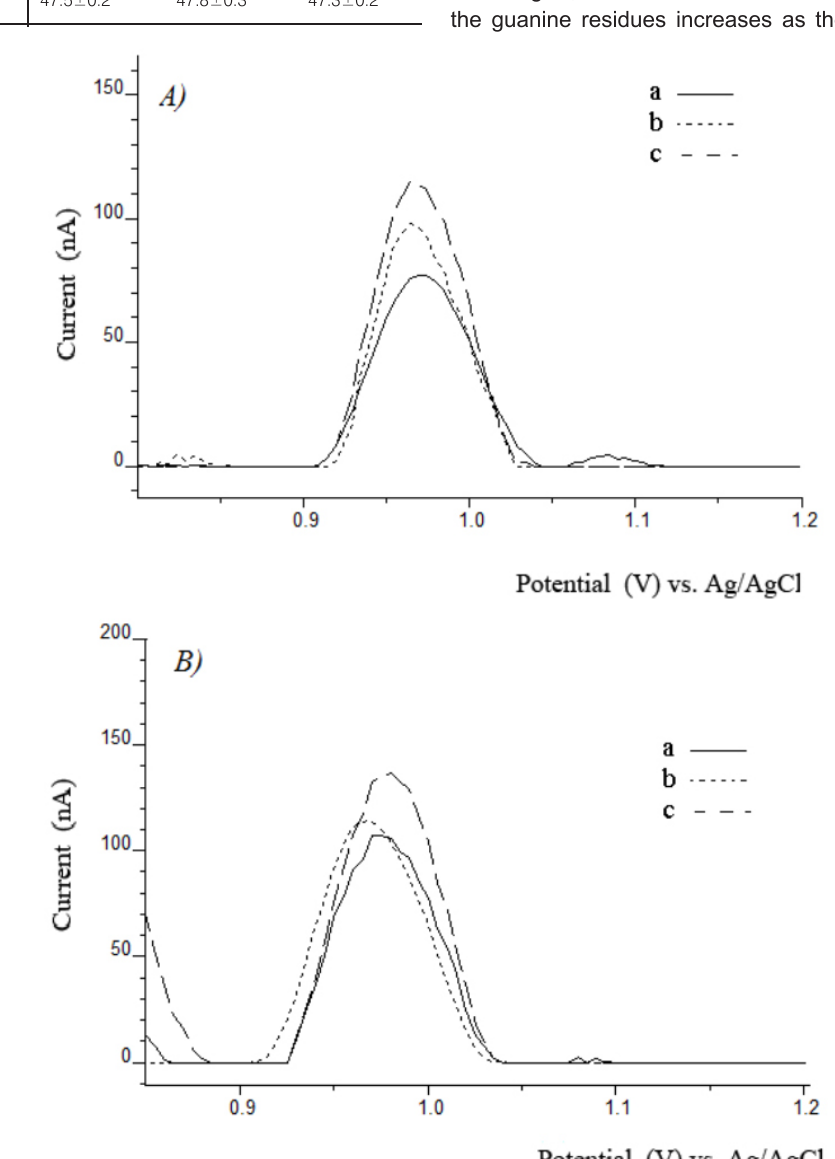
Figure 8. (A,B) DPV signal of two different samples of dsDNA isolated from rat liver tissues at different pretreated electrodes: a) MWNTPE b) MWNTPE , c) MWNTPE . Other conditions as described in the section 2 3